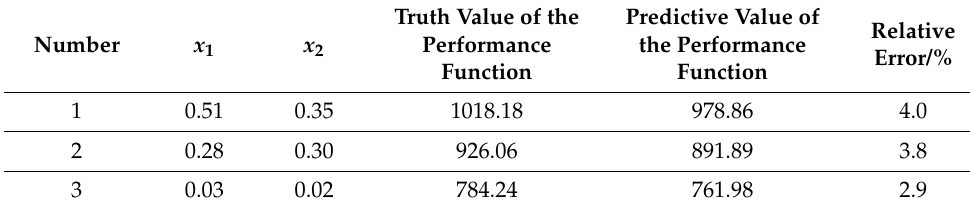
Table 3. The test samples and function values of Case 1.